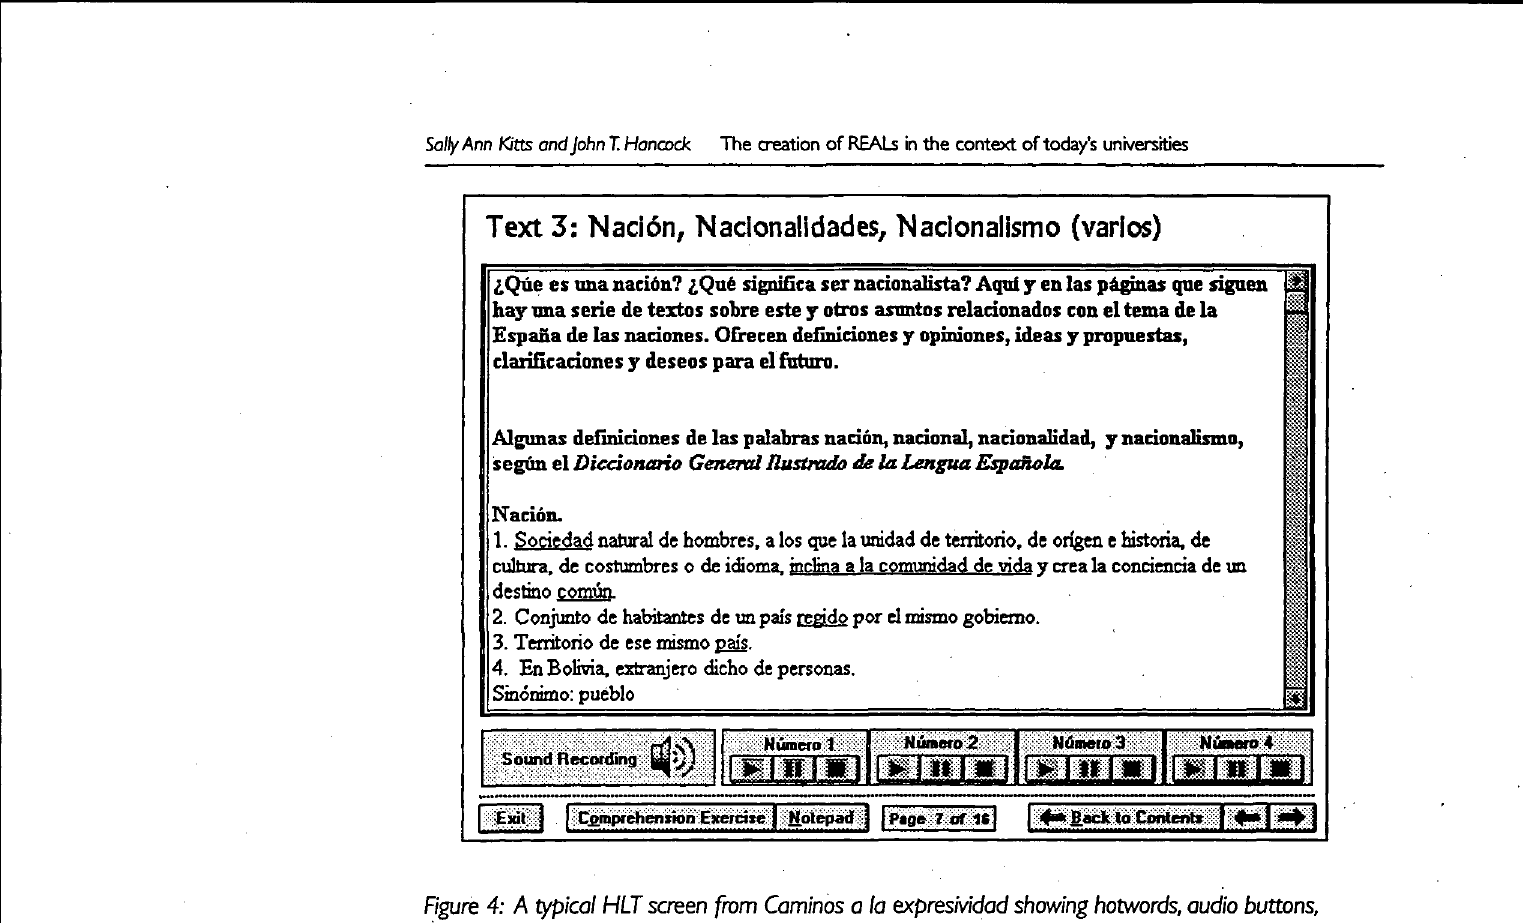
Figure 4: A typical HLT screen from Caminos a la expresividad showing hotwords, audio buttons, navigation buttons, notepad facility and button linking to self-assessment comprehension